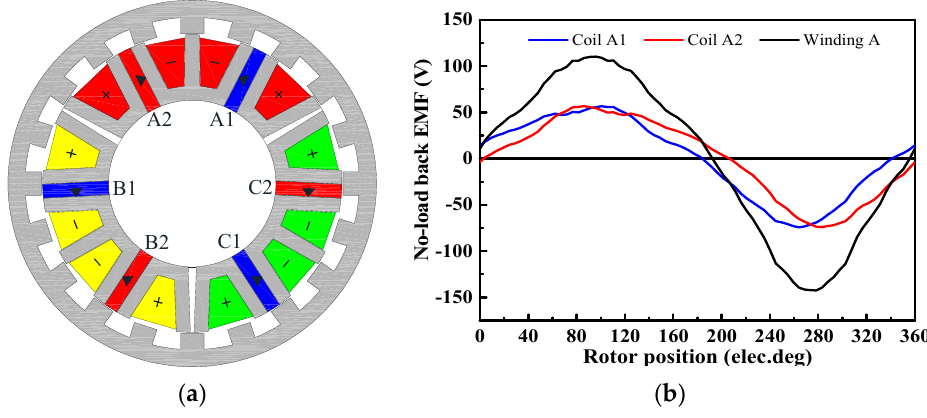
Figure 4. 12-slot/20-pole MSOR-FSPM motor: ( a ) Cross-sectional view of the 12-slot/20-pole MSOR-FSPM motor; ( b ) No-load back-EMF waveforms of coil A1, coil A2, and winding A.